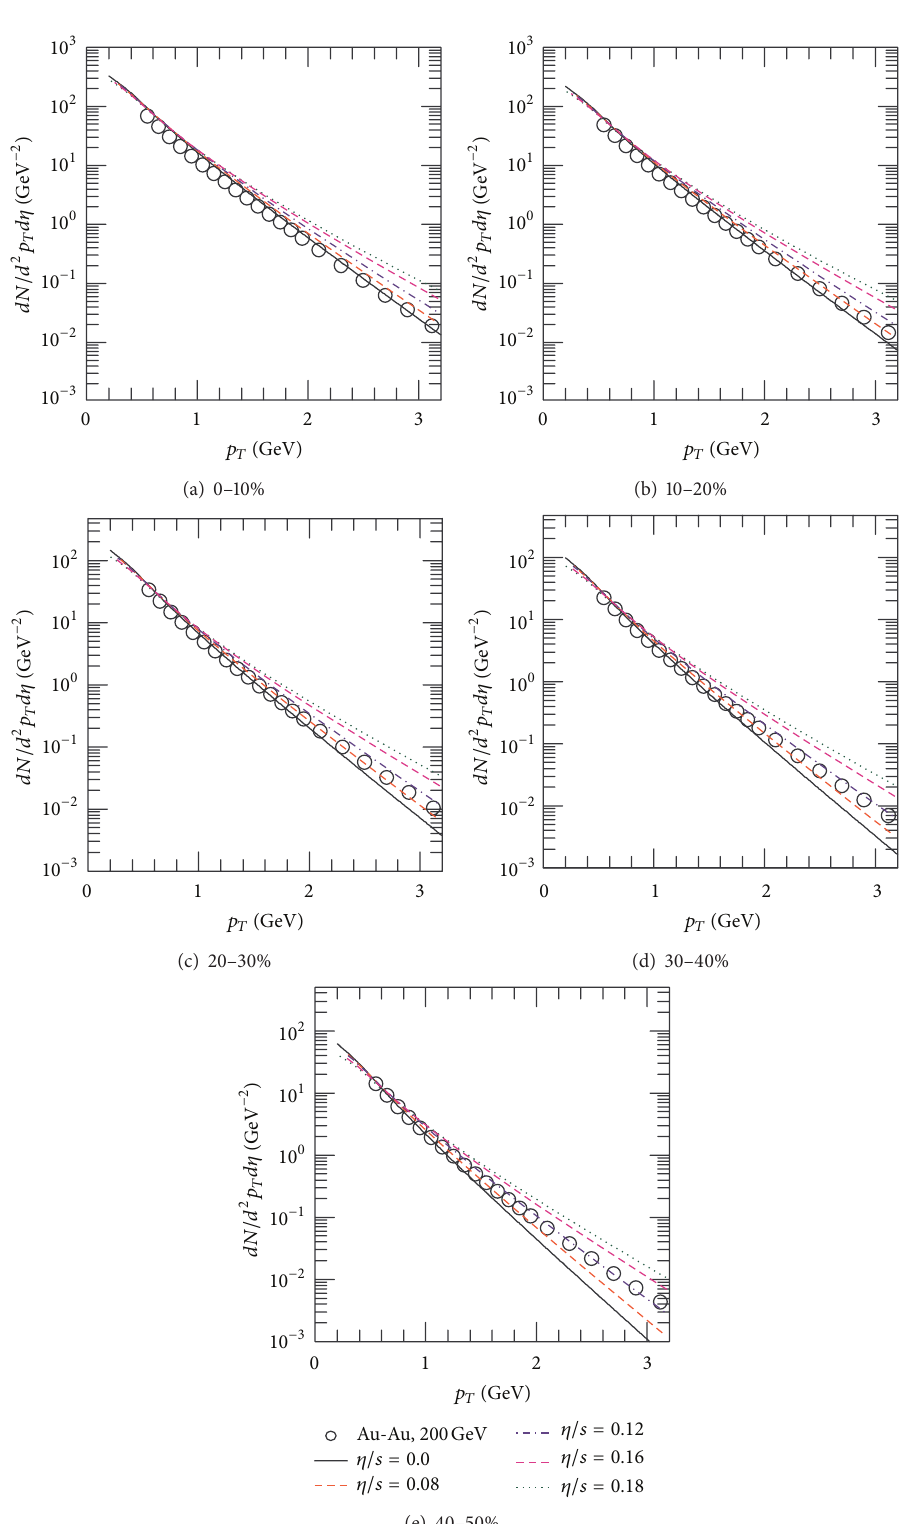
Figure 9: PHENIX measurements of charged particles 𝑝 𝑇 spectra in √𝑠 𝑁𝑁 = 200 GeV Au+Au collisions are compared with viscous hydrodynamic simulations. The figures are from